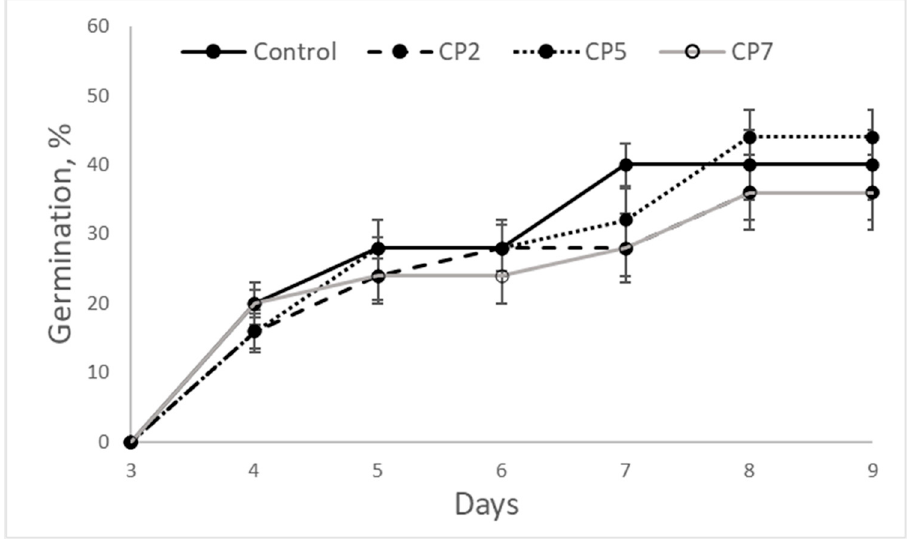
Figure 2. Germination kinetics of Stevia rebaudiana seeds (mean ± SEM, n = 4). Table 1. Indices of germination kinetics of Stevia rebaudiana seeds derived from Richards plots. Group Vi, % Me, Days Qu, Days Control 40.0 ± 5.0